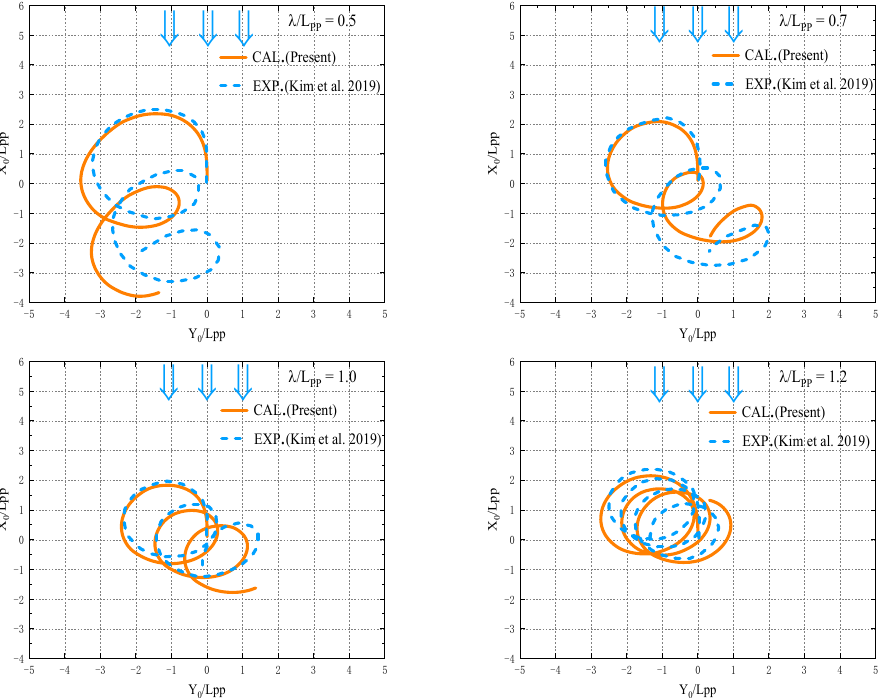
Figure 24. Comparisons of the turning trajectory of −35° turns with the wavelength variation in the head waves. The experimental values were reproduced from [8], with permission from Elsevier, 2022.